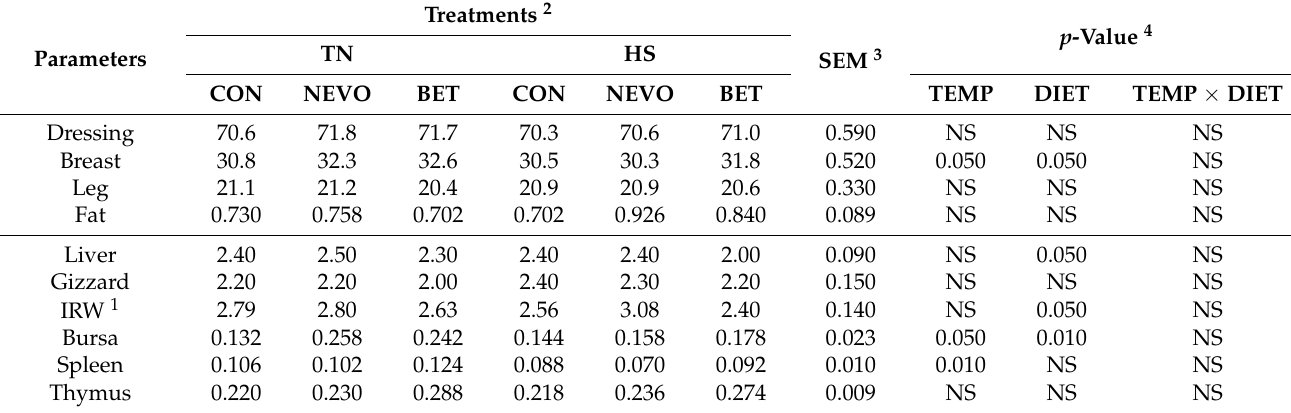
Spleen Thymus 0.220